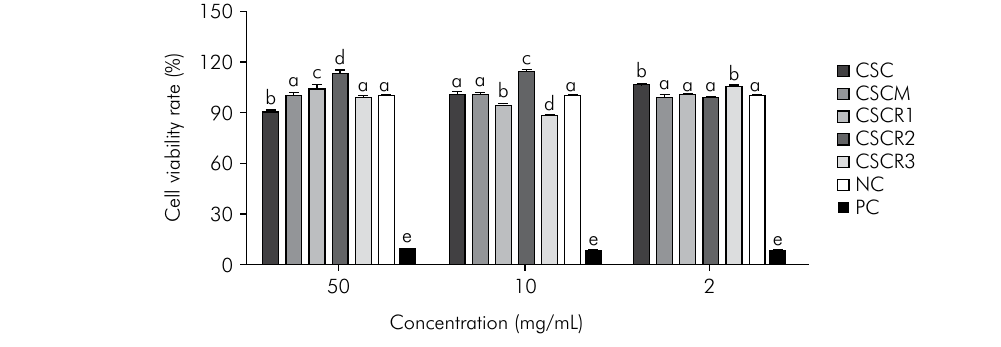
Figure 1. Cell viability of SAOS-2, after being cultivated with eluates of the cements in different concentrations (50mg/mL; 10mg/mL; 2mg/mL) in a period of 24 hours. NC represents the negative control (untreated cells), and PC represents the positive control (3% hydrogen peroxide) for 10 minutes. Different letters represent results that differed statistically among one another, within the same concentration. Analysis of Variance, Bonferroni (p<0.05).